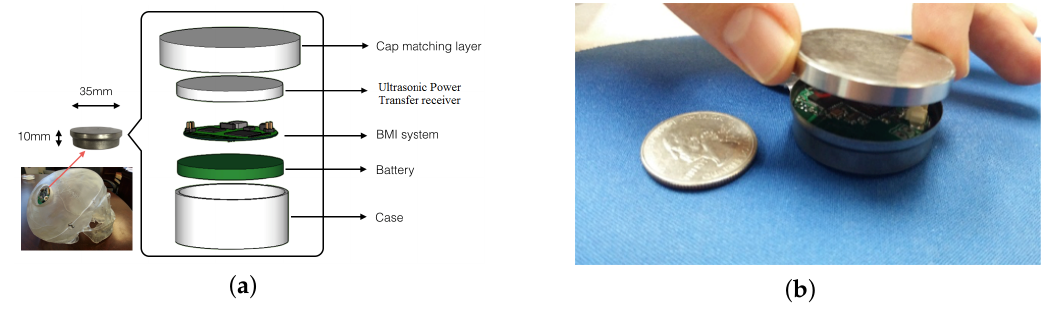
Figure 1. ( a ) Implantable bidirectional brain machine interface (BBMI) module in titanium casing with 3D representation. ( b ) Implantable BBMI module size in comparison with a